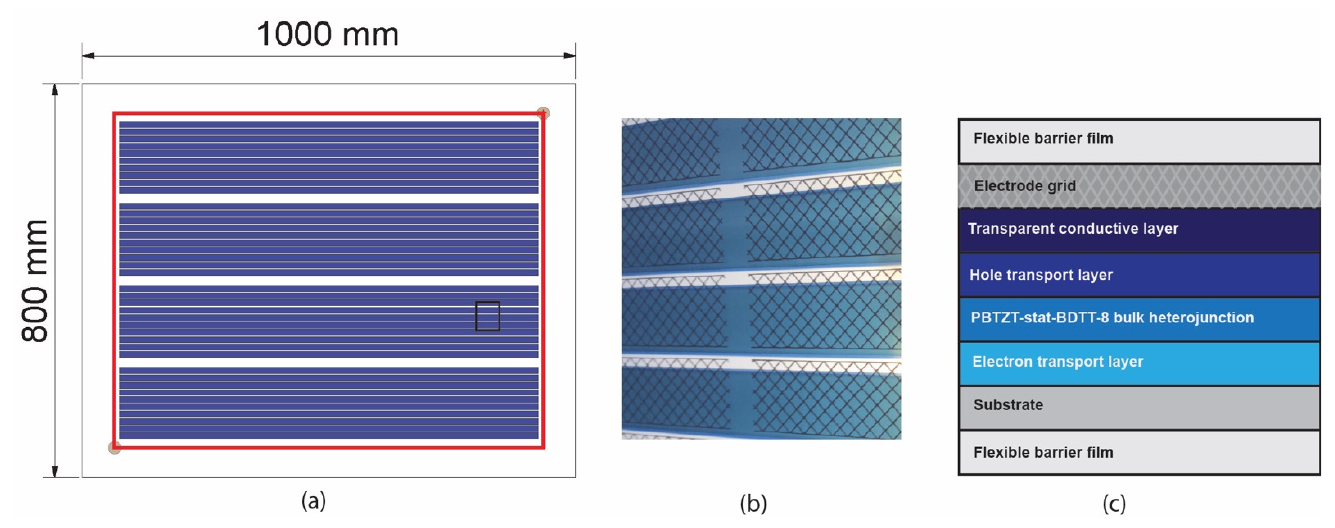
Figure 1. ( a ) OPV panel schematic with 4 serially connected OPV module strings, each containing 10 blue cells; ( b ) a close image of the OPV cells; ( c ) the material architecture of the OPV devices used in the study.